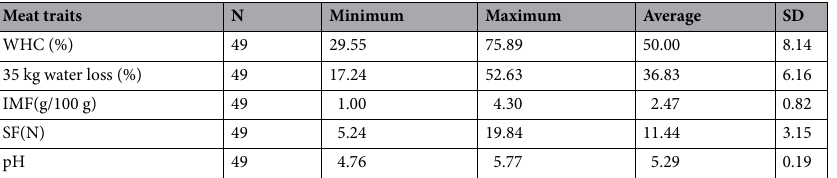
Table 1. Summary of statistical data of Chinese Simmental beef cattle quality traits. WHC water holding capacity, IMF intramuscular fat, SF shear force, SD standard deviation.